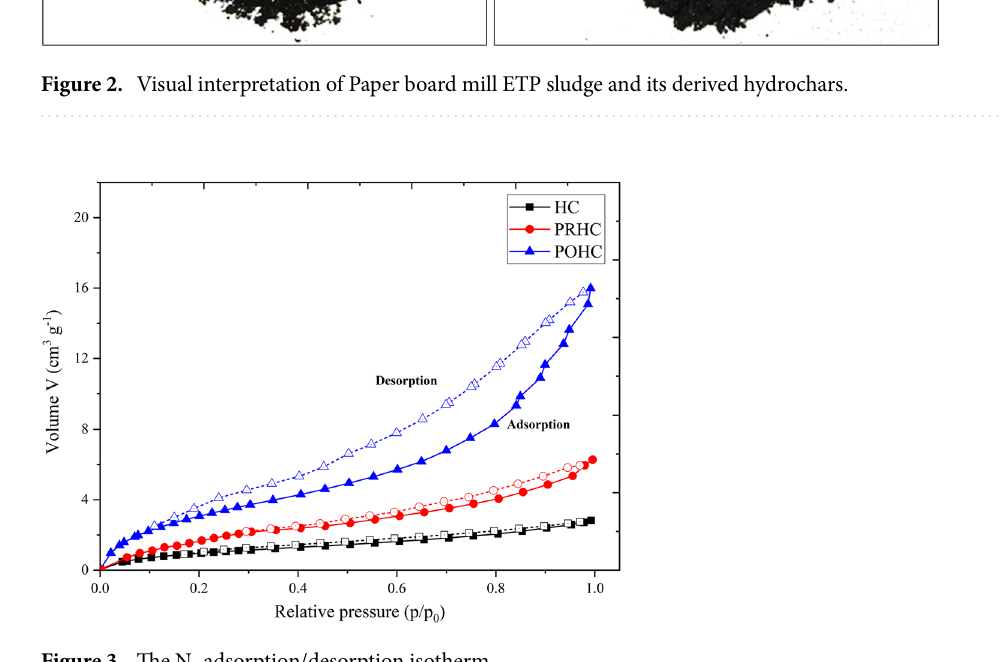
Figure 3. The N 2 adsorption/desorption